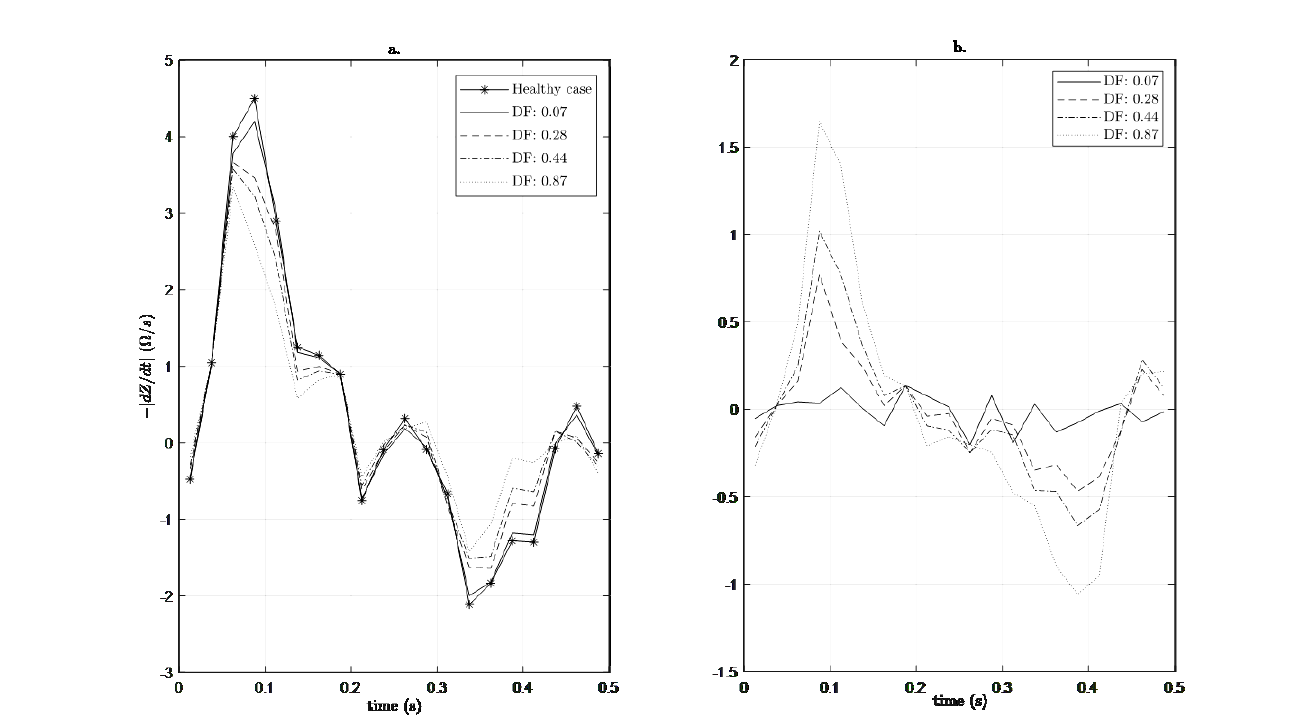
Fig.14: a. 𝐻𝐶̂ 𝐶,4𝑃𝐶𝐸 (𝑡) and 𝐷𝐶̂ 𝐶,4𝑃𝐶𝐸 (𝑡) for different damage factors, b. 𝑌̂ 𝐶,4𝑃𝐶𝐸 for different damage